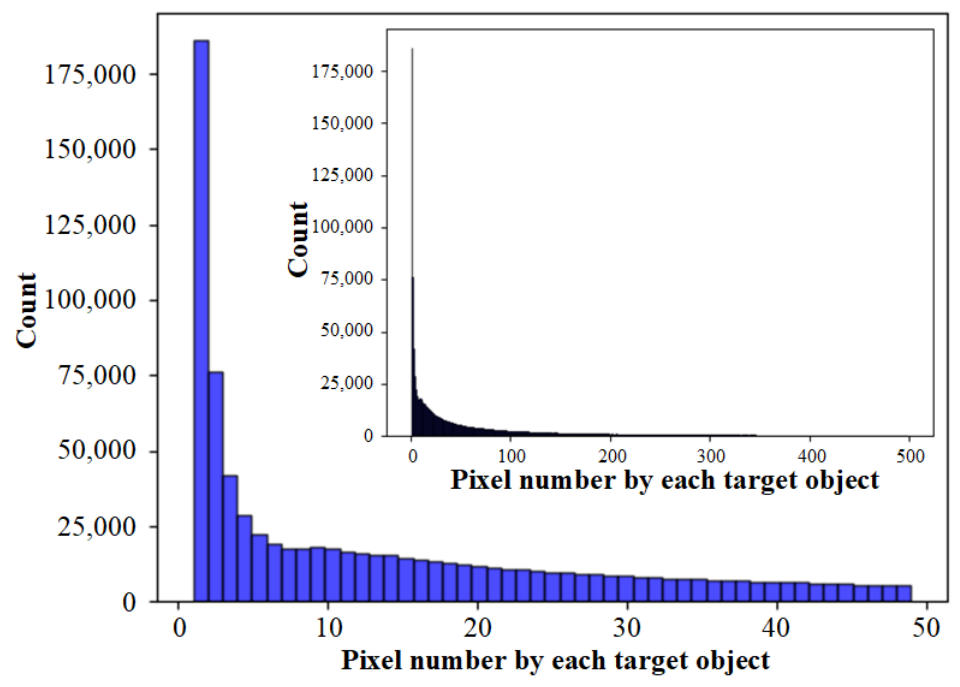
Figure 21. The distribution of the pixel number by each target